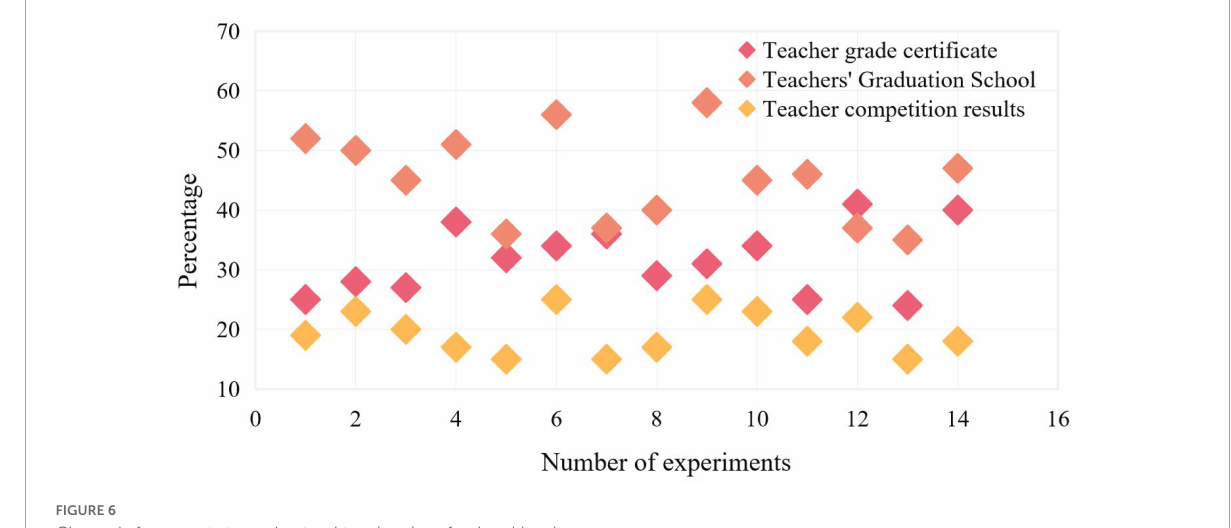
FIGURE6 Channels for parents to understand teachers’ professional level.